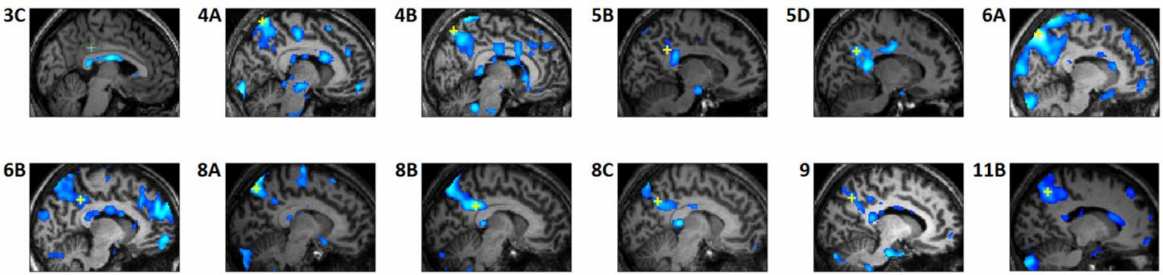
Figure 2. REM-locked fMRI signal decrease in precuneus/posterior cingulate cortex. Each study constitutes an independent within-subject study. Labels indicate participant and study number, e.g., participant 5 contributed five studies (5A–5E), 5B is the second study and 5D is the fourth study. Talairach coordinates and t values of the maximum signal decrease voxels (yellow crosshair) are shown in Table 2. All panels show sagittal views. All studies were thresholded at uncorrected p < 0.05 (see color scales in Figure 3) and additionally at a spatial extent of <5 contiguous voxels. Table 2. REM-locked fMRI signal decrease in precuneus/posterior cingulate cortex.